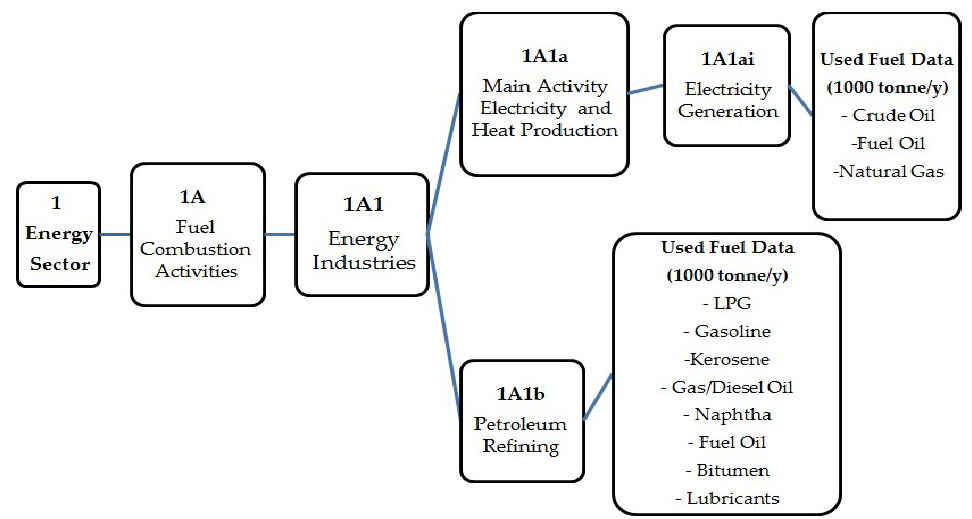
Figure 4. Flowchart of the main categories in the energy sector in the Intergovernmental Panel on Climate Change (IPCC) methodology used in the current study for electricity generation and oil refining in Iraq.